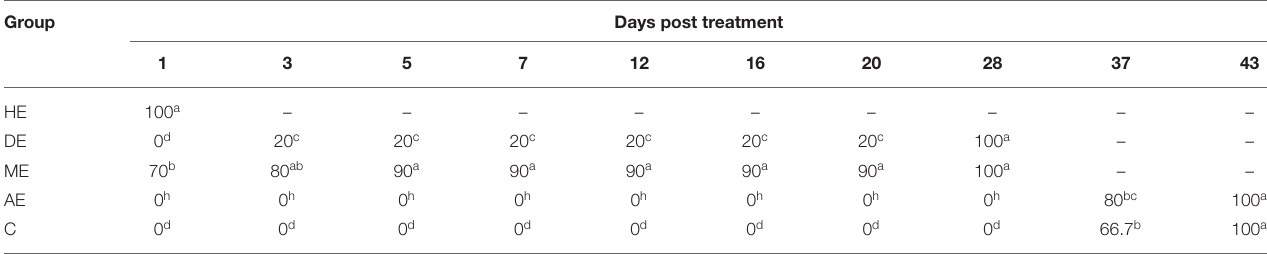
Small superscript letters (a, b, c, d, e, and f) in the columns and the rows denote significant difference (P < 0.05). HE, hexane neem seed extract emulsion; DE, dichloromethane neem seed extract emulsion; ME, methanol neem seed extract emulsion; C, control; AE, aqueous neem seed extract emulsion.